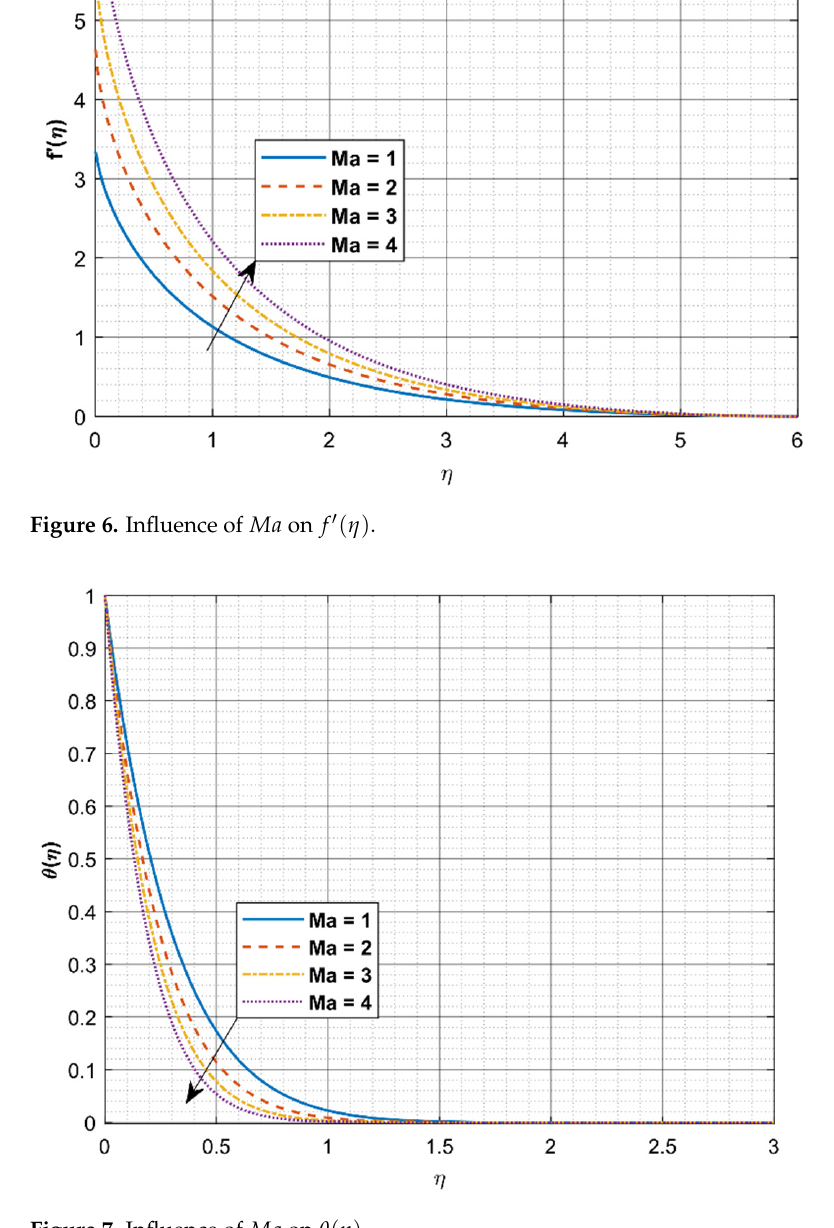
Figure 7. Influence of M a on ( )